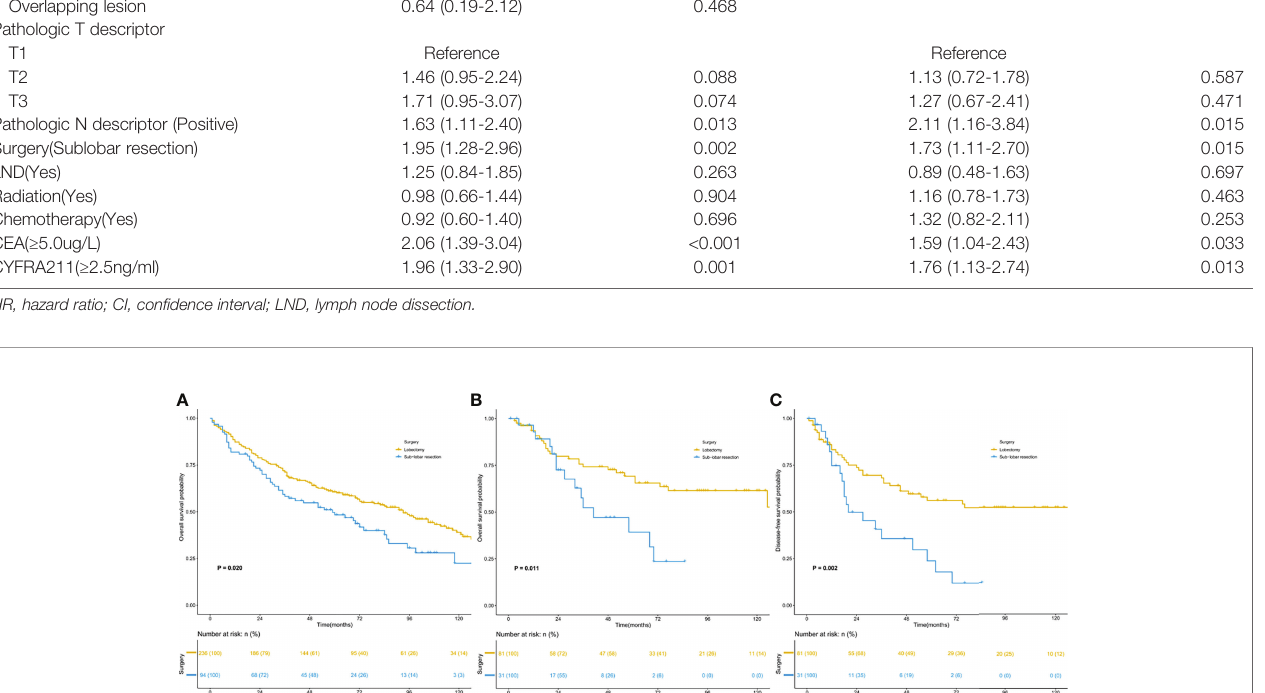
Frontiers in Oncology |